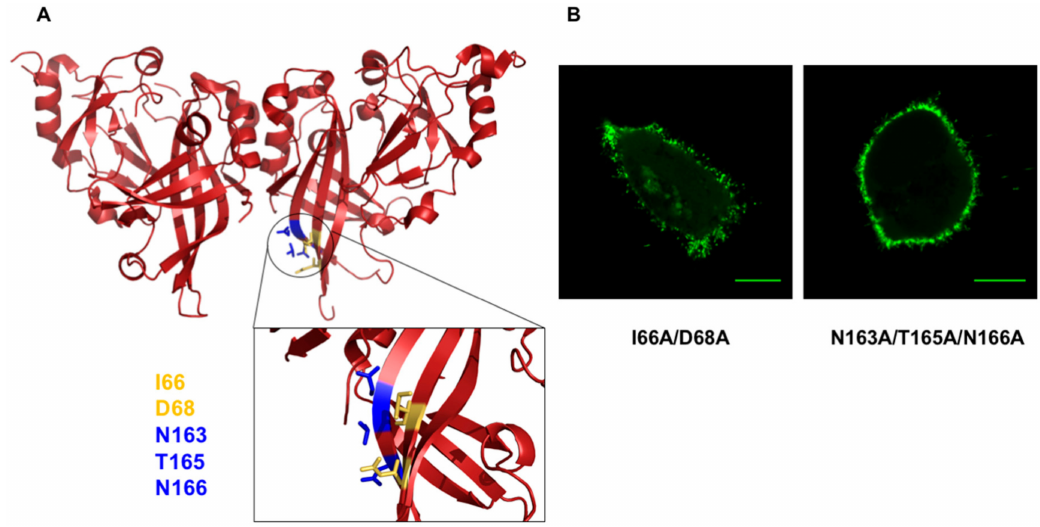
Figure 3. Multiple amino acid mutations to the mVP40 N-terminal domain (NTD )region adjacent to the C-terminal domain (CTD) hydrophobic loop failed to cause changes in plasma membrane localization compared to WT mVP40. ( A ) NTD region of mVP40 where the multiple amino acid mutants were made. ( B ) Cellular localization of the I66A / D68A and N163A / T165A / N166A mutant proteins following 14 h post-transfection in COS-7 cells. Scale bar = 10 µ